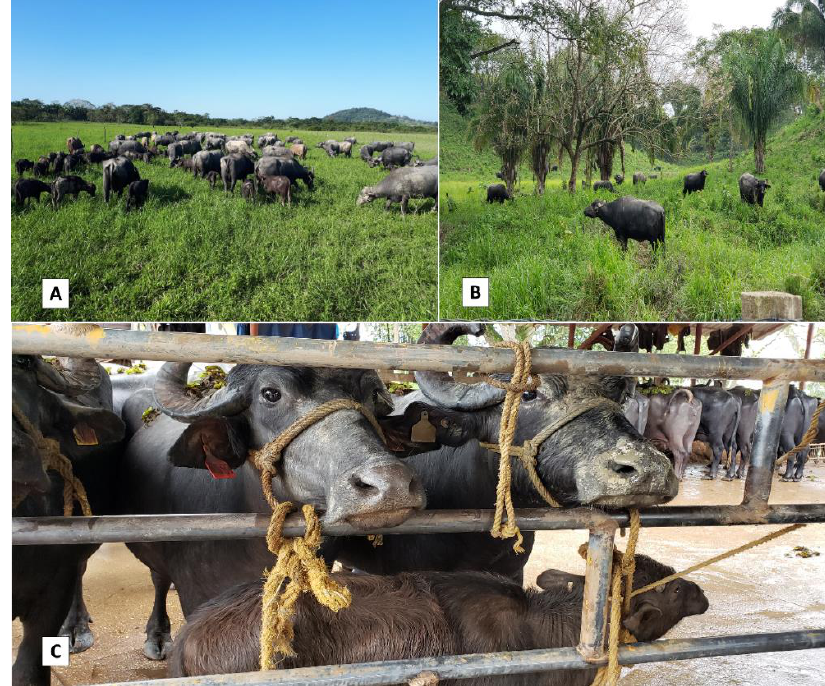
Figure 3. Dual-purpose buffalo production system. ( A , B ) The Latin American humid tropics offer abundant forage resources, including shrubs and trees, to which buffalo are optimally adapted. ( C ) Milking with the presence of calves stimulates milk ejection and favors the development of the calves themselves, which is the basis of a dual